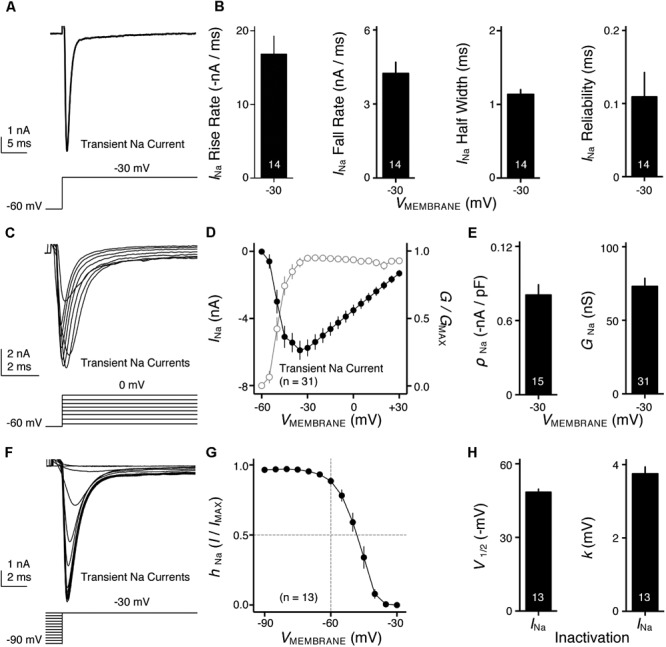
Voltage dependent sodium (NaV) current properties of NMc neurons. (A) Representative transient NaV current traces (INa) recorded from an NMc neuron, in response to step depolarization to –30 mV (holding voltage = –60 mV). (B) Population data showing the NaV current (INa) kinetics, including rise rate (in absolute value), fall rate and half width, along with reliability. These properties were measured at the membrane voltage (VMEMBRANE) of –30 mV. Numbers in bars represent sample size. (C) Representative transient NaV current traces (INa) in response to varying step depolarizations from –40 to 0 mV (Δ step = 5 mV, holding voltage = –60 mV). (D) Population data showing the NaV current-voltage relationship (filled circles), along with normalized NaV conductance (G/GMAX) as a function of membrane voltage (VMEMBRANE) for NMc neurons (open circles). (E) Population data showing the NaV current density (ρNa) and conductance (GNa) at the membrane voltage (VMEMBRANE) of –30 mV. (F) Representative transient NaV current traces (INa) in response to step depolarization to –30 mV following pre-pulse holding voltages clamped from –90 to –30 mV (Δ step = 5 mV). (G) Population data showing voltage dependence of NaV current inactivation for NMc neurons. hNa was calculated as the NaV current recorded from each holding voltage (I) normalized to the maximum current across all trials (IMAX) and plotted as a function of the pre-pulse holding voltage. (H) Population data showing the half inactivation voltage (V1/2) and slope factor (k) for voltage dependence of inactivation. Error bar = standard error.